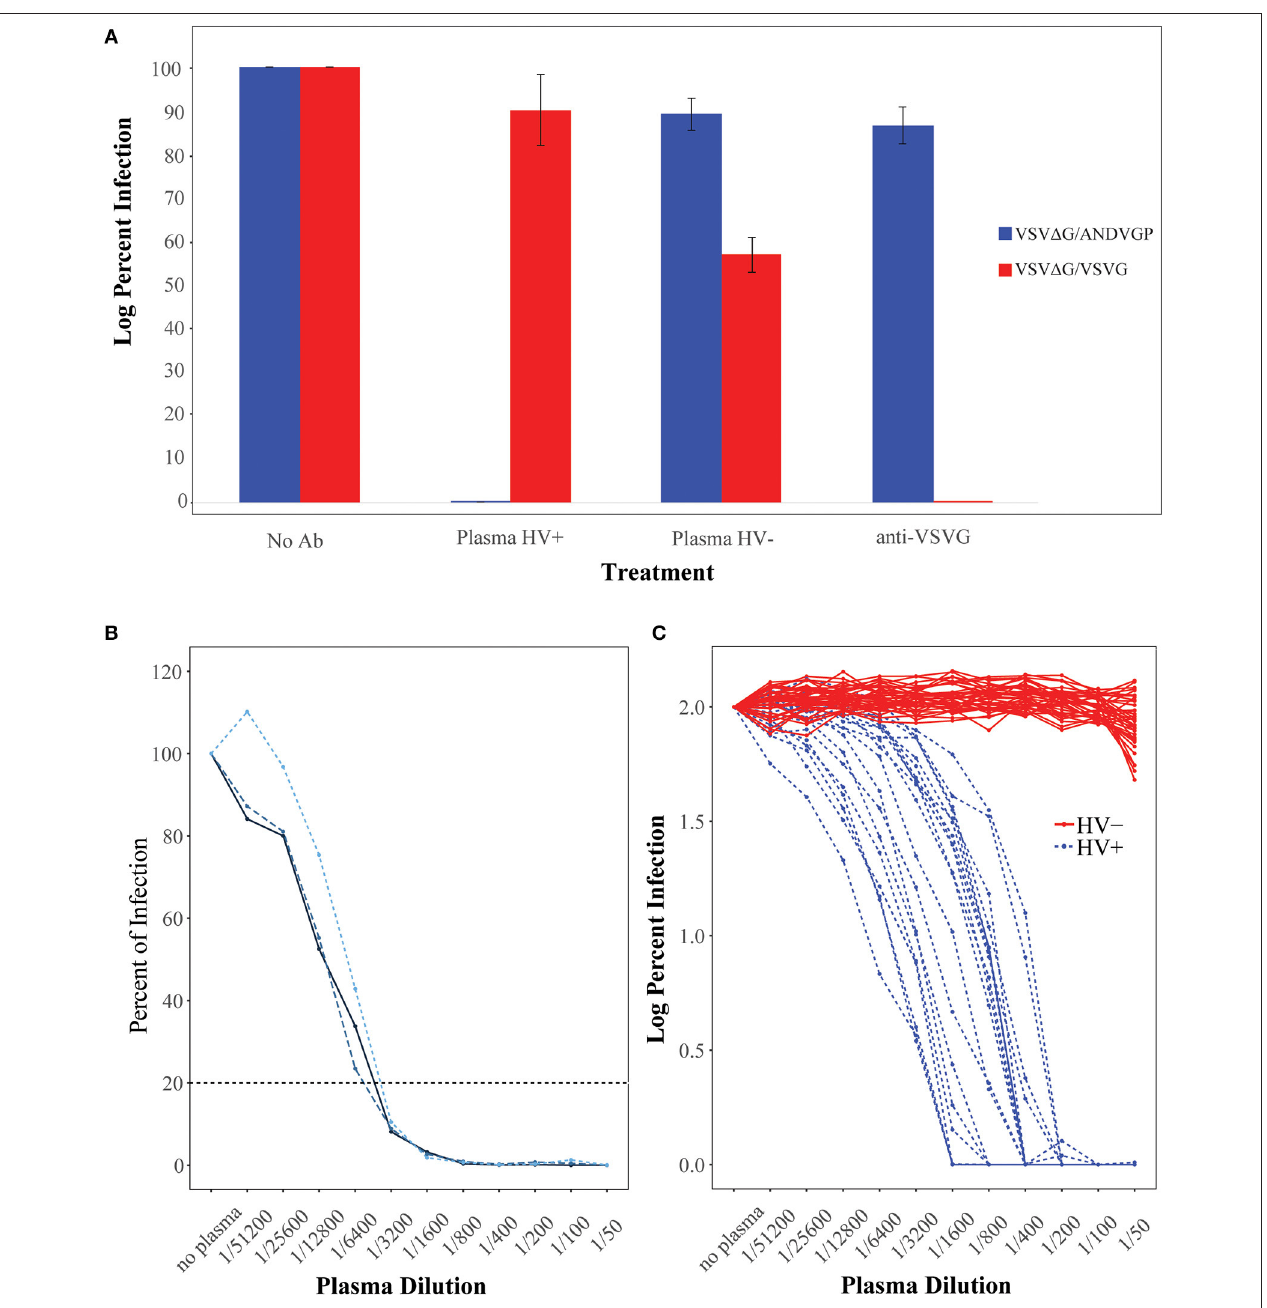
FIGURE 1 | Characterization of Andes orthohantavirus (ANDV) glycoprotein (GP)- or vesicular stomatitis virus (VSV) G-decorated Renilla luciferase reporter viruses. (A) VSV 1 G/ANDVGP (blue) and VSV 1 G/VSVG (red) pseudovirus (Psdv) infectivity in Vero E6 cells. Psdv infection (percent of infection) was measured with (i) medium alone (no Ab), (ii) hantavirus-positive patient plasma (HV + ) diluted 1/50, (iii) hantavirus-negative patient plasma (HV–) diluted 1/50, and (iv) an anti-VSV G antibody diluted 1/50. Each bar represents the mean and standard error. (B) Three independent experiments of full titration curves for one plasma sample from a hantavirus-positive patient. Percent of infection by VSV 1 G/ANDVGP was measured by luciferase activity (RLU) at each plasma dilution and neutralizing antibody (NAb) titer calculated when there was an 80% inhibition of virus infection. (C) Full titration curves of 60 human plasma samples. Sera from 20 hantavirus-positive donors (HV + in blue) and 40 hantavirus-negative donors (HV– in red) were tested for NAbs against VSV 1 G/ANDVGP. Y axis shows the percent of infection (log 10 ) of each dilution point.